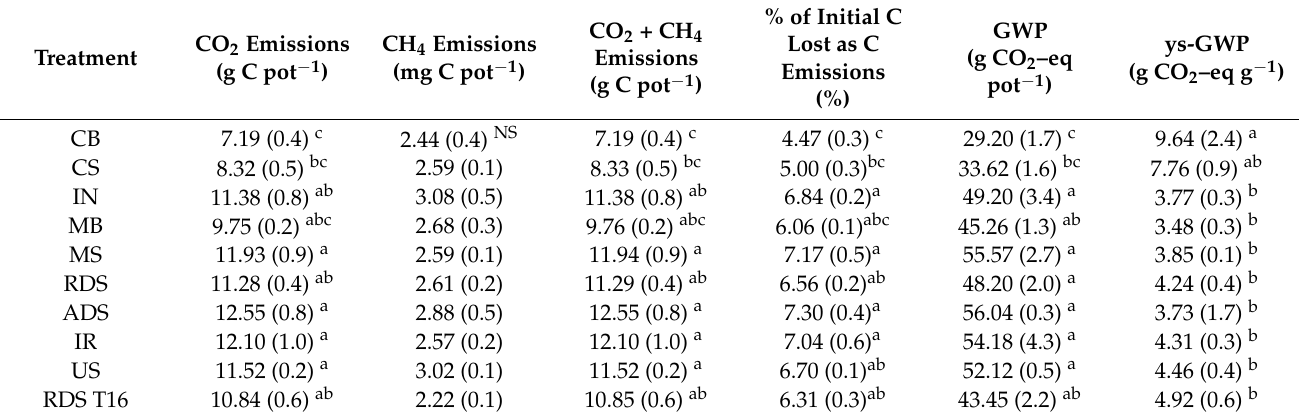
Table 3. Cumulative carbon dioxide and methane emissions from treatments, as well as total C emission (CO 2 –C + CH 4 –C) and total C emitted as a percentage of initial C content in each treatment (soil, soil + stubble, soil + fertilizer or soil + stubble + fertilizer). Global warming potential (GWP) and yield-scaled GWP (ys-GWP). Values followed by different letters in the same column are significantly different ( p < 0.05) based on the Tukey test. Standard error values are displayed in parentheses (mean, n = 3). The absence of letters in the same column = not significant ( NS